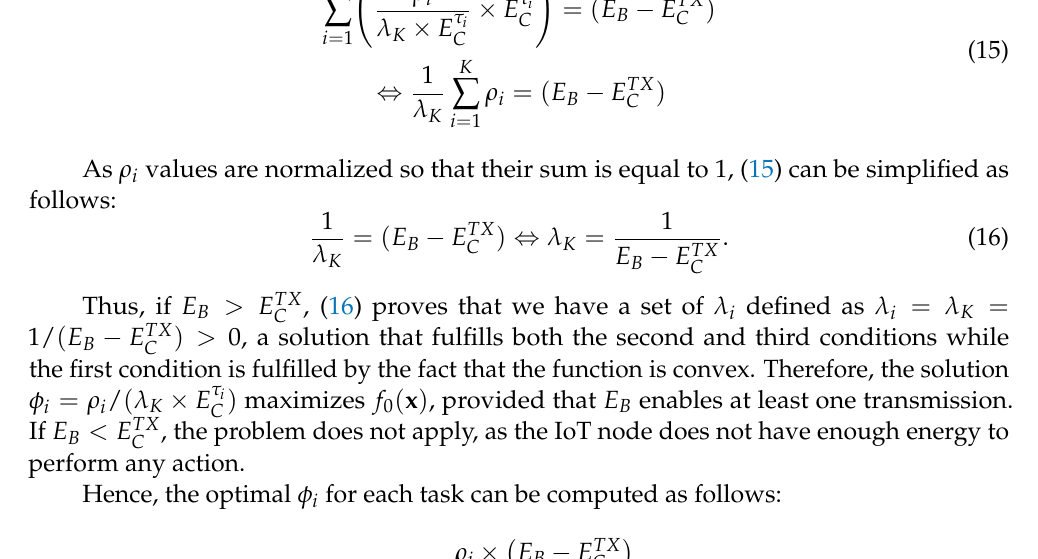
Algorithm 1 proposes the integration of the optimal φ i . It defines E max